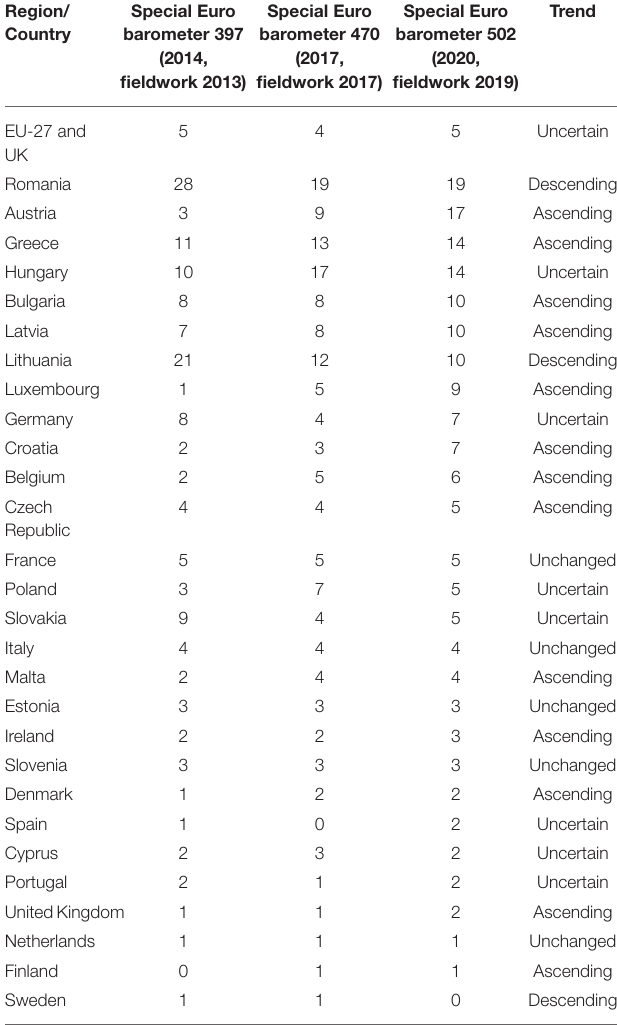
TABLE 1 | Trends in informal payments to healthcare practitioners in the EU-27 and the UK (%; 2013, 2017,